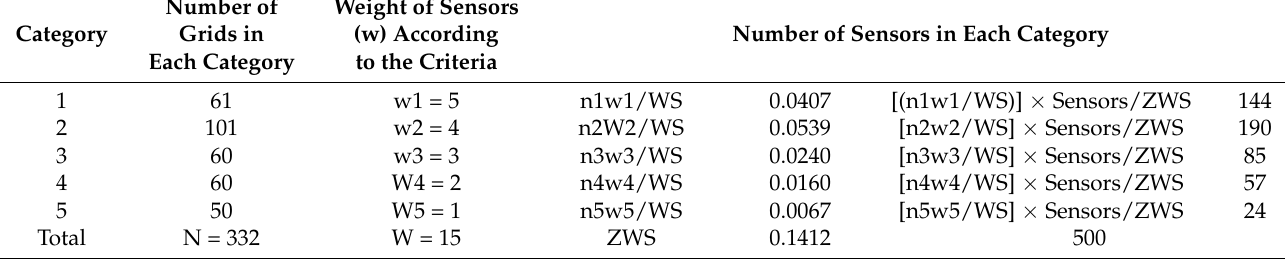
Table 5. Sensor count calculation for Pune.